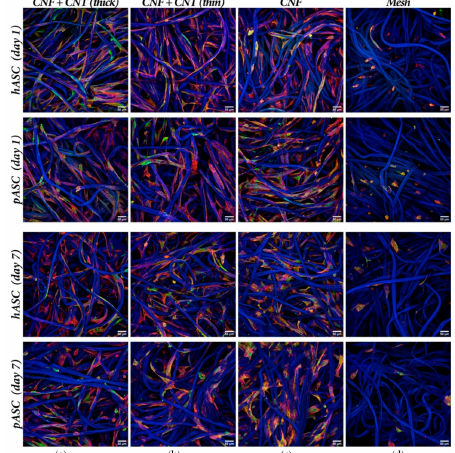
Figure A1. Human adipose tissue-derived stem cells (hASC) and porcine adipose tissue-derived stem cells (pASC) on days 1 and 7 after seeding on a cellulose mesh with thick or thin CNF + MWCNT coating (column ( a ) and ( b ), respectively), with CNF coating (column ( c )), and without any coating (column ( d )). Cells were stained by immunofluorescence for vinculin (green), with TRITC-conjugated phalloidin for F-actin (red) and with Hoechst #33258 for the nuclei (blue). Cellulose mesh had autofluorescence in the blue channel. Dragonfly 503 spinning disk confocal microscope with a Zyla 4.2 PLUS sCMOS camera, objective HC PL APO 20x / 0.75 IMM CORR CS2. Scale bar: 50 µ